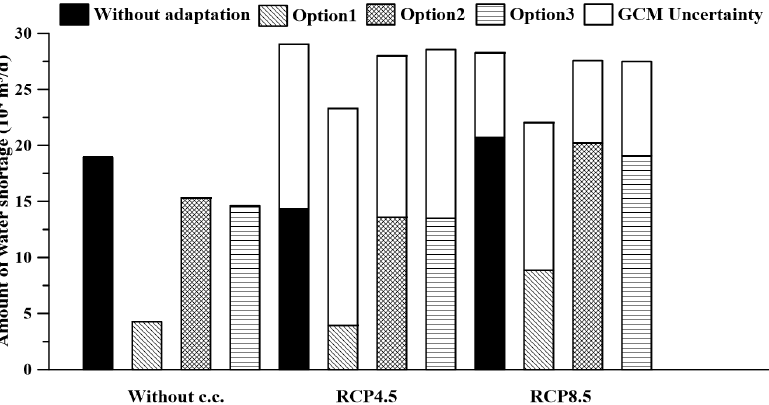
Figure 12. Amounts of water shortage of Formosa Plastics Corporation (FPC) under ten-year return period.